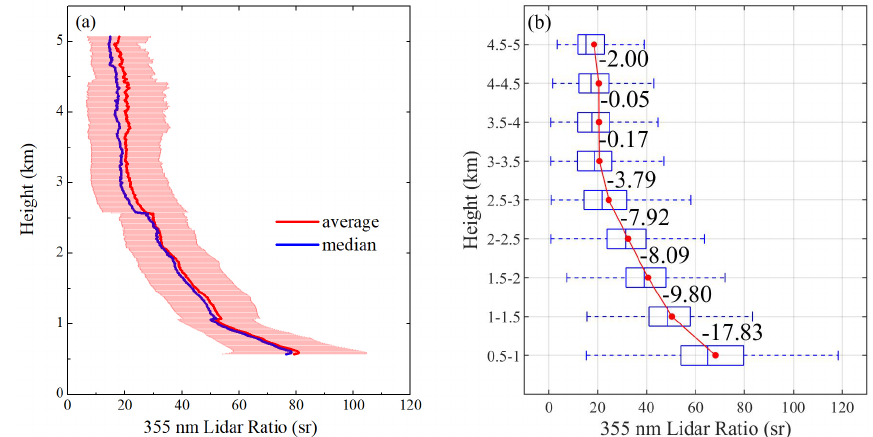
Figure 2. General variation in LR. (a) Averaged profile of LR. The red line is the averaged profile, the blue line is the median profile, and the red shadow is the error bar, indicating the standard deviation. (b) Averaged LR in different altitude ranges. The red line is the line of average values at different heights. The numbers between two points are the slopes between the two points.